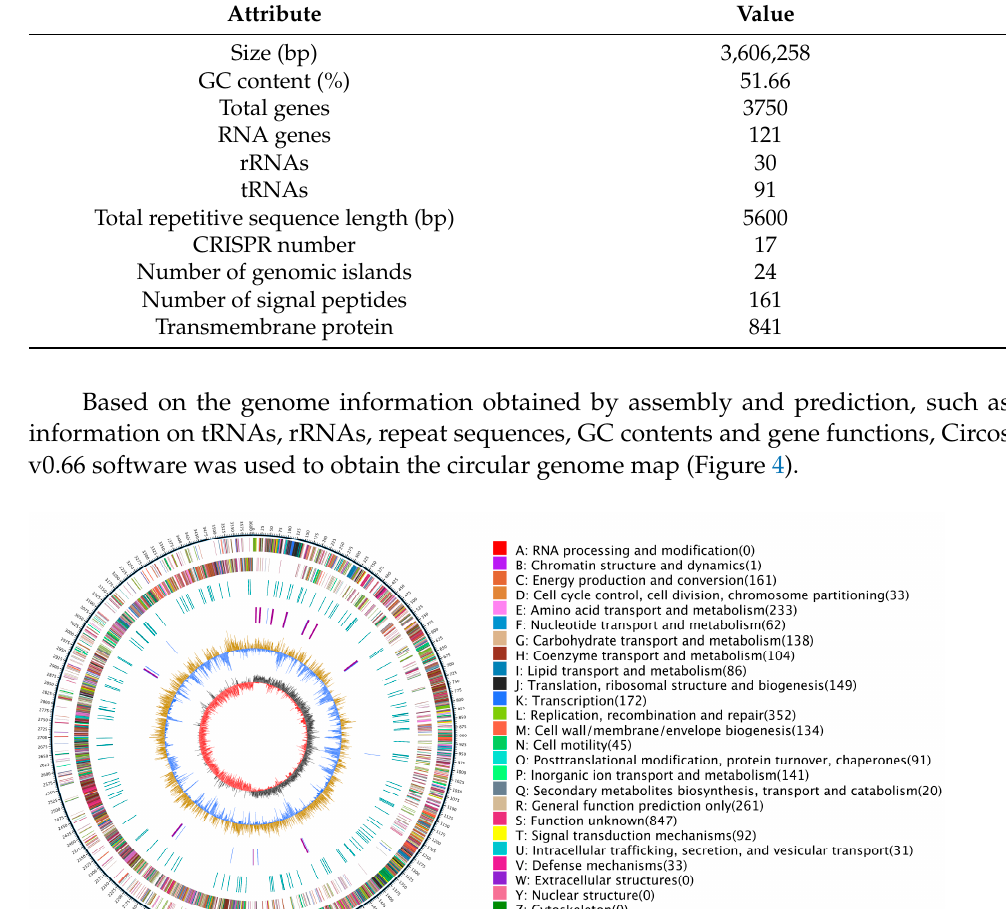
Table 2. General genomic characteristics of G. stearothermophilus H6.